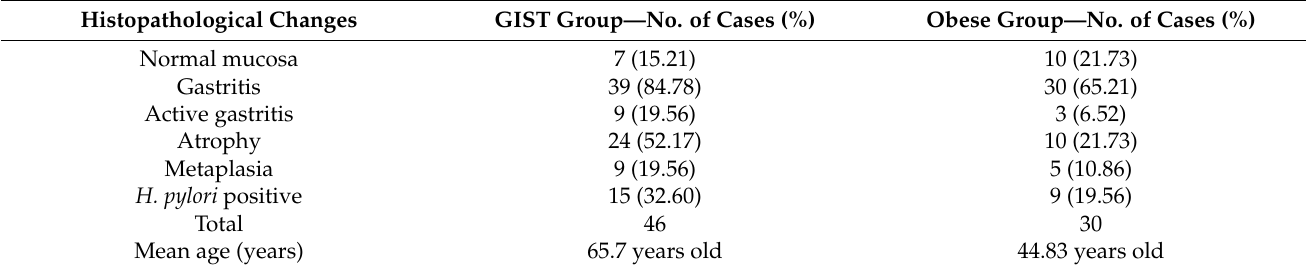
Table 2. Histological changes in the overlying mucosa of GISTs and in the mucosa of obese patients group. Histopathological Changes GIST Group—No. of Cases (%) Obese Group—No. of Cases (%)